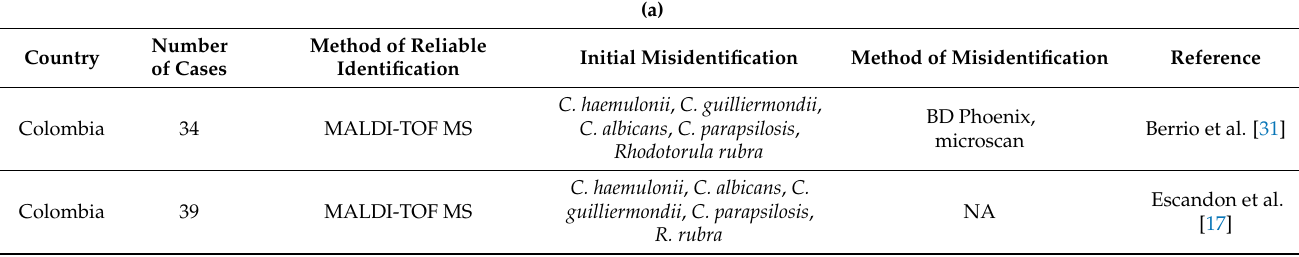
Table 2. Microbiologic characteristics of C. auris isolates in children. ( a ) Microbiologic identification of C. auris isolates. ( b ) Susceptibility profile of C. auris